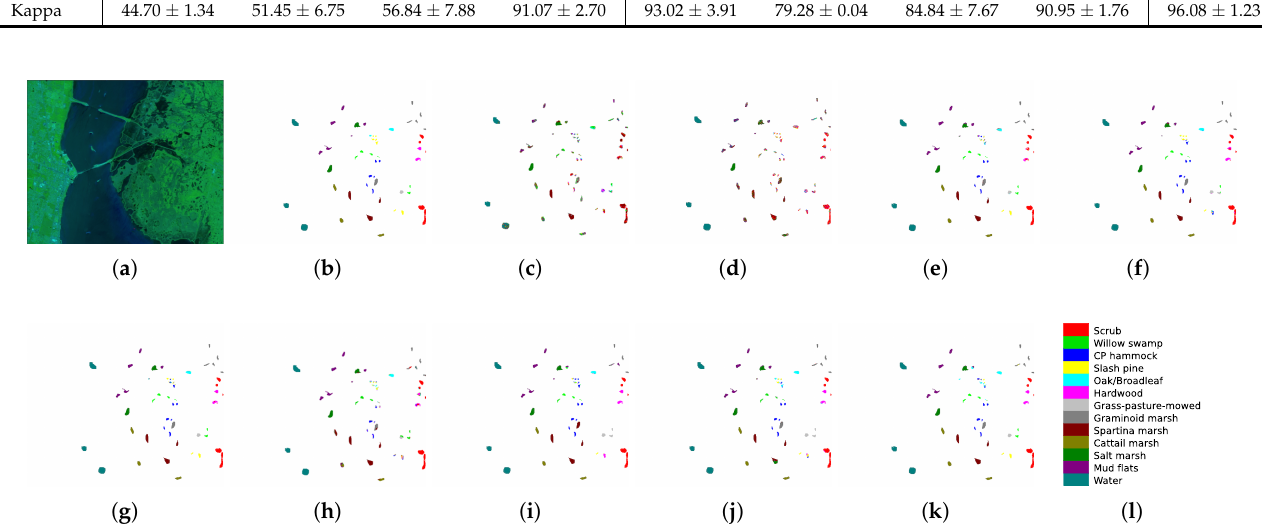
Figure 9. Classification maps of different methods on the KSC dataset. ( a ) False-color; ( b ) Ground truth map; ( c ) 2D-CNN; ( d ) 3D-CNN; ( e ) Res-Net; ( f ) SSRN; ( g ) A2S2K; ( h ) MAFN; ( i ) DBDA; ( j ) A-SPN; ( k ) AETF-Net; ( l ) Color